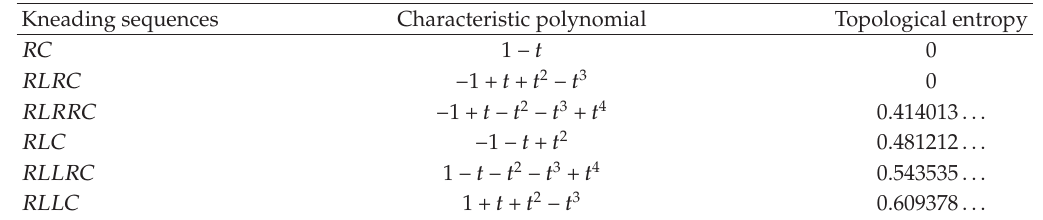
Figure 8, the corresponding kneading orbits are as follows: 1-period— C ∞ , 2-period— (cid:3) RC (cid:4) 4-period— (cid:3) RLRC (cid:4) period— (cid:3) RLLC (cid:4)